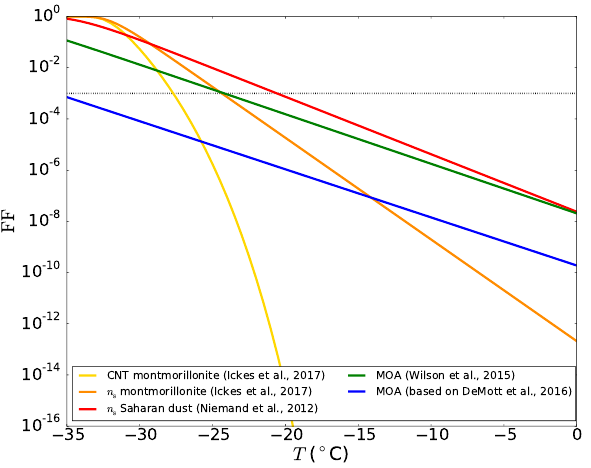
Figure 6. Frozen fraction (FF) vs. temperature ( T ) of the various parameterisations used for dust aerosol (montmorillonite and Saha- ran dust) and MOA in this study. Spherical aerosol of radius 0.5µm and an ice nucleation time of 10s for the CNT method are assumed. In addition to the parameterisations previously discussed in the text, an additional n s -based parameterisation for montmorillonite is also plotted following Ickes et al. (2017). The dotted black line indicates the freezing onset (0.001